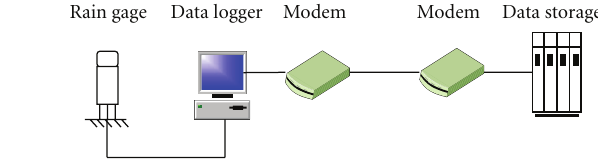
Figure 1: Experimental system used for measuring the rain rate.